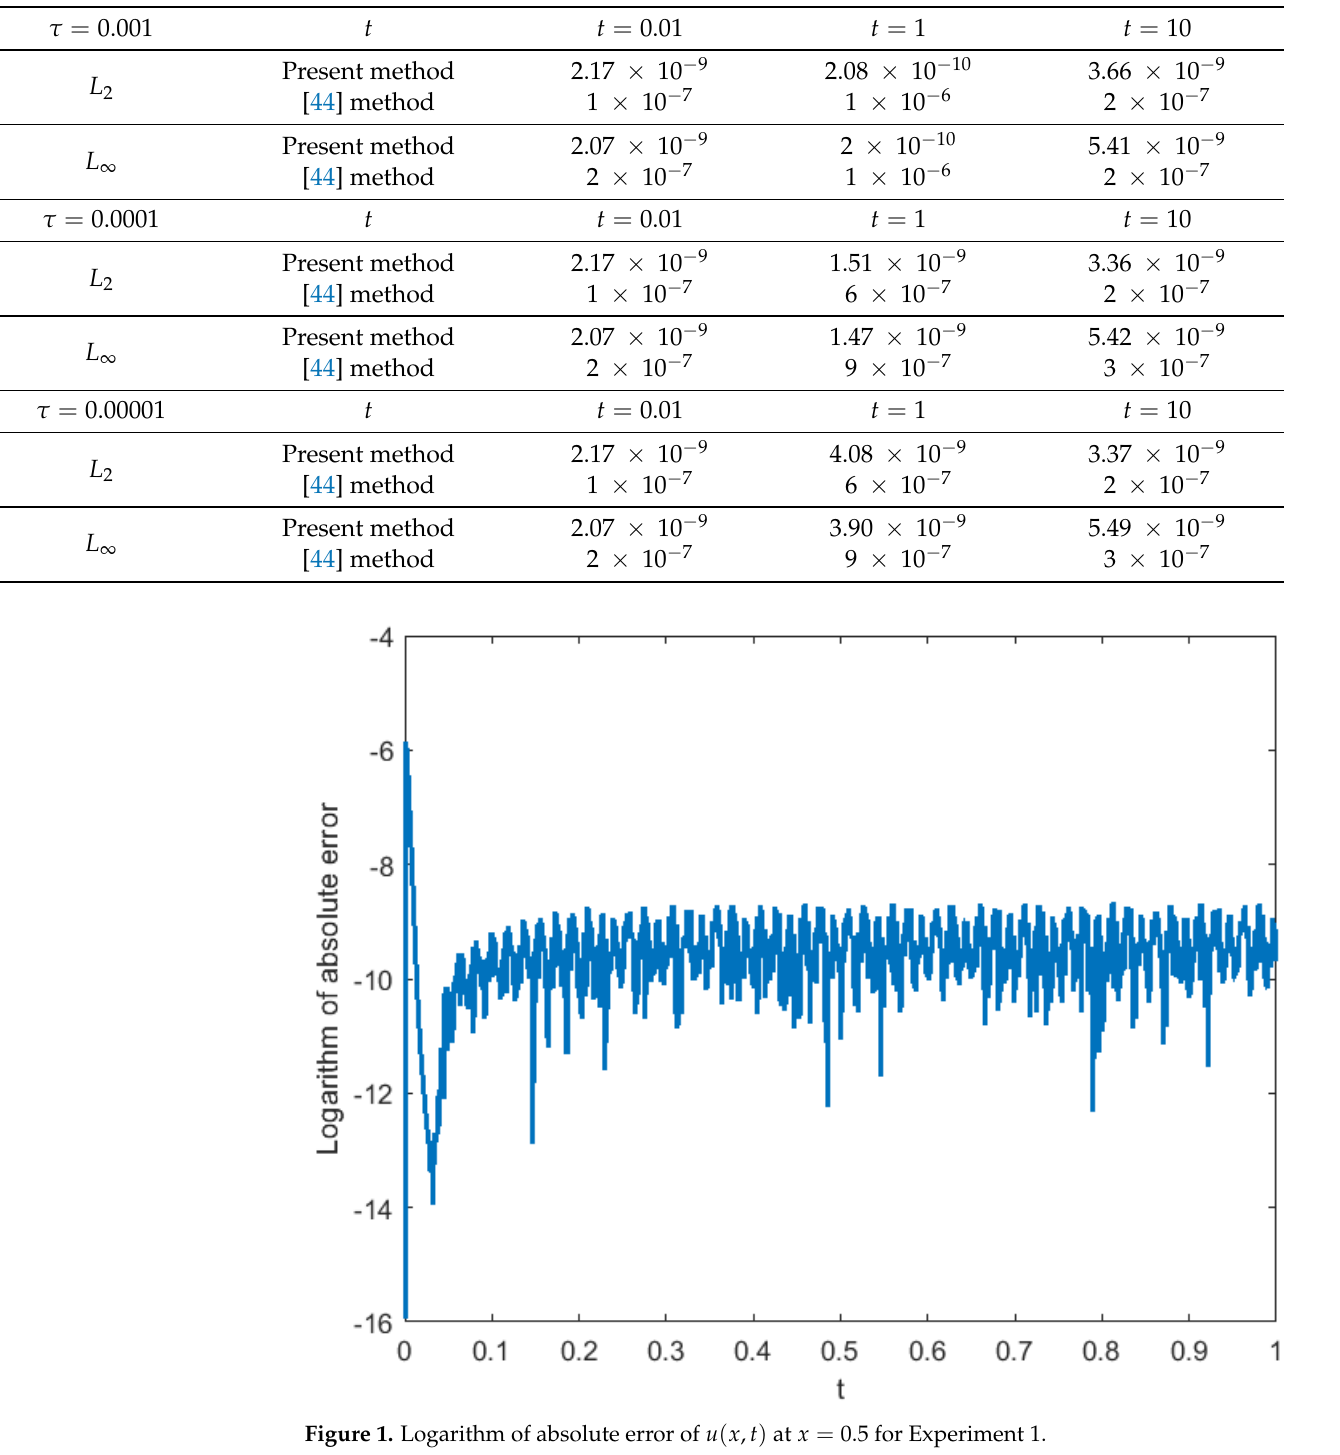
Figure 1. Logarithm of absolute error of u ( x , t ) at x = 0.5 for Experiment